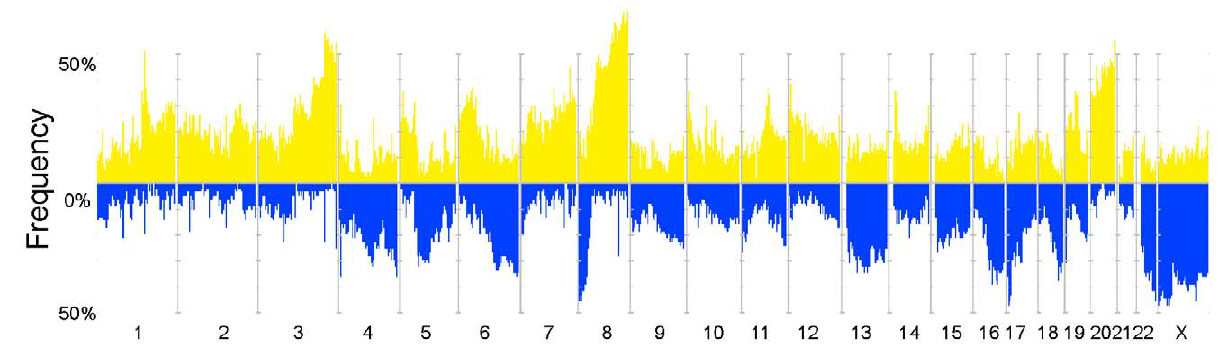
Figure 1. Overview of genomic aberrations in the ovarian cancer dataset (N=72). Frequency of occurrence of genomic gains (yellow) and losses (blue) across the genome, depicted in chromosome order from 1p to